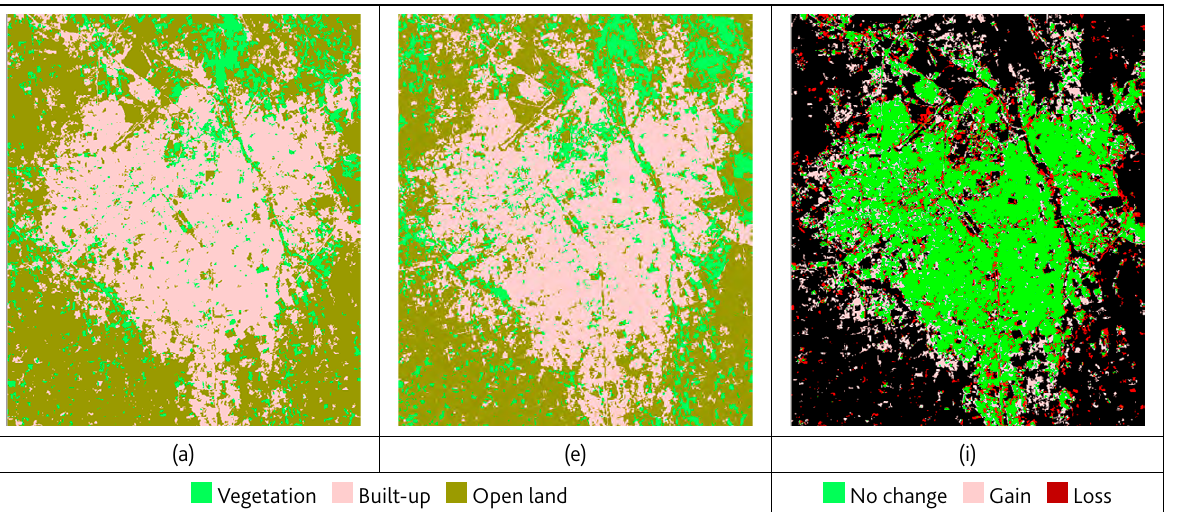
Figure 6. OBCD results using ABETC for Rajkot Data set. (a) Classified Image of the year 2014 (b) Classified Image of the year 2021 (c) Built-up area change map of